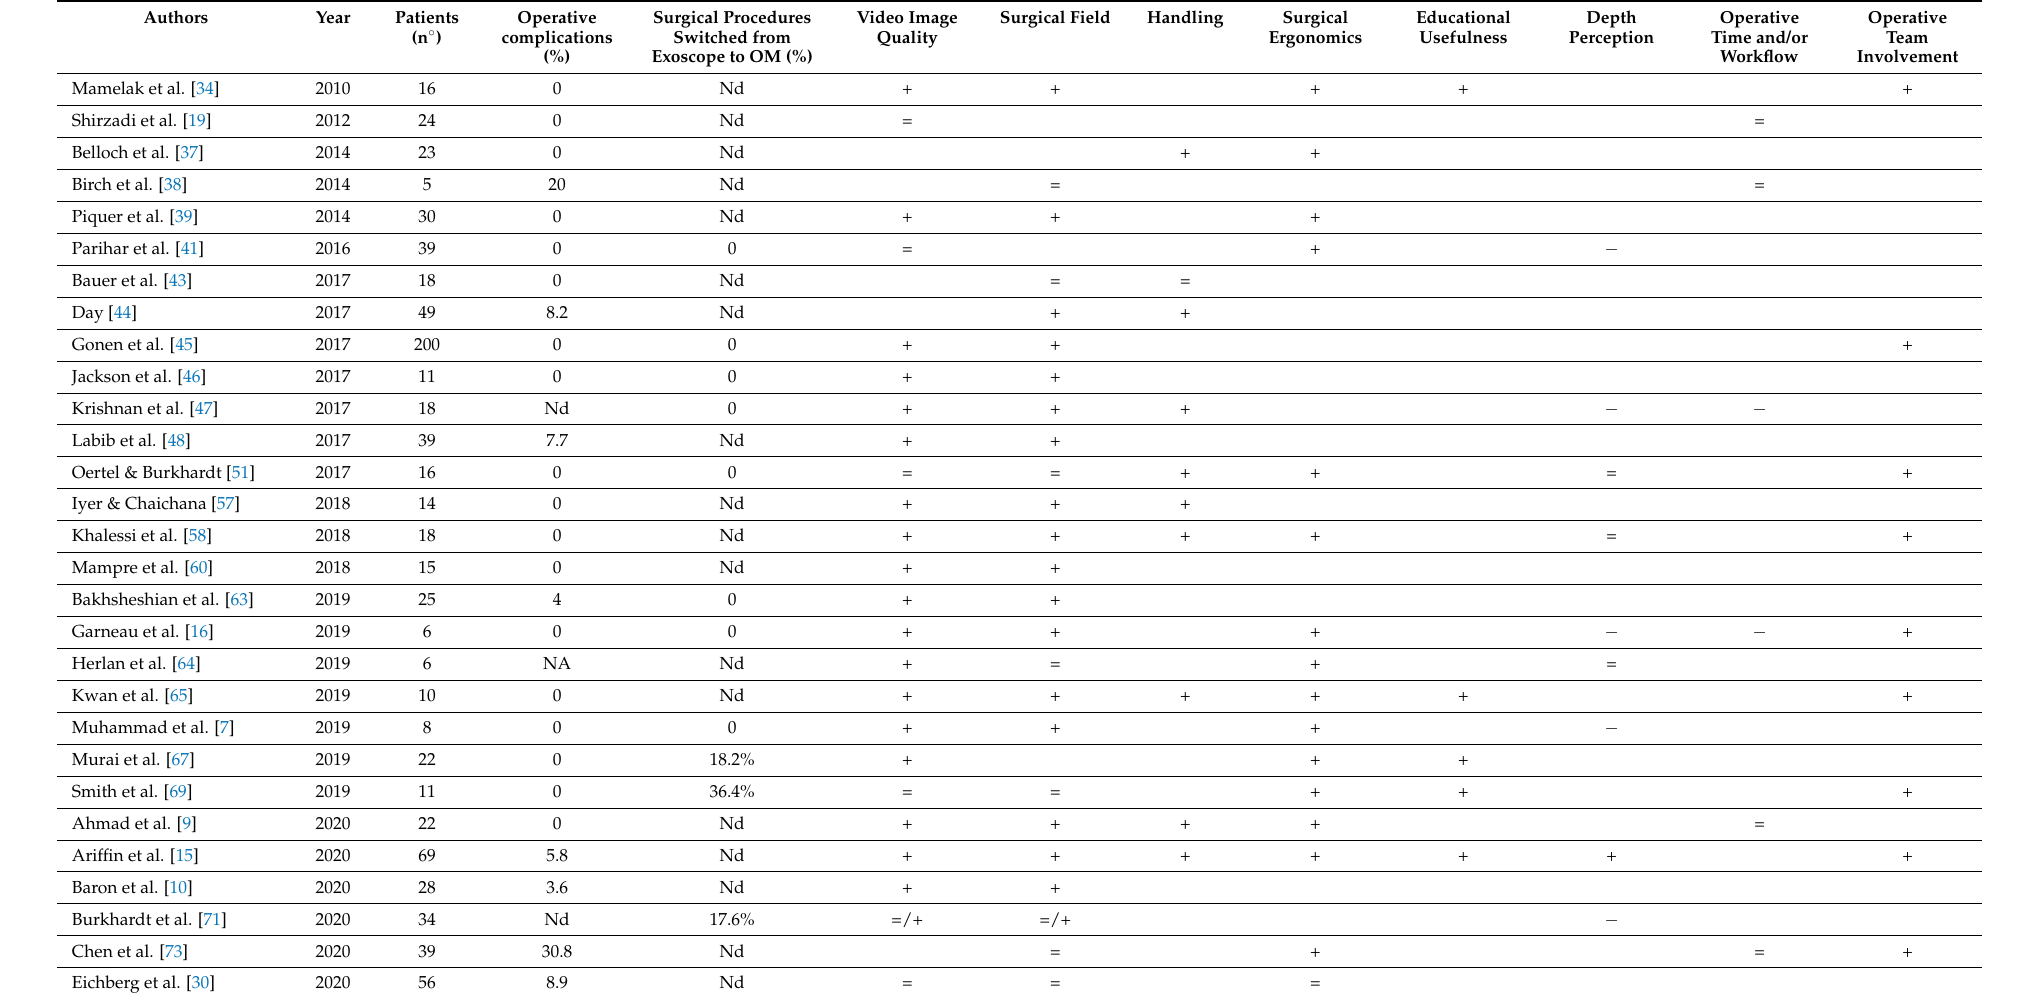
Table 5. Summary of evaluation exoscopic surgical procedures